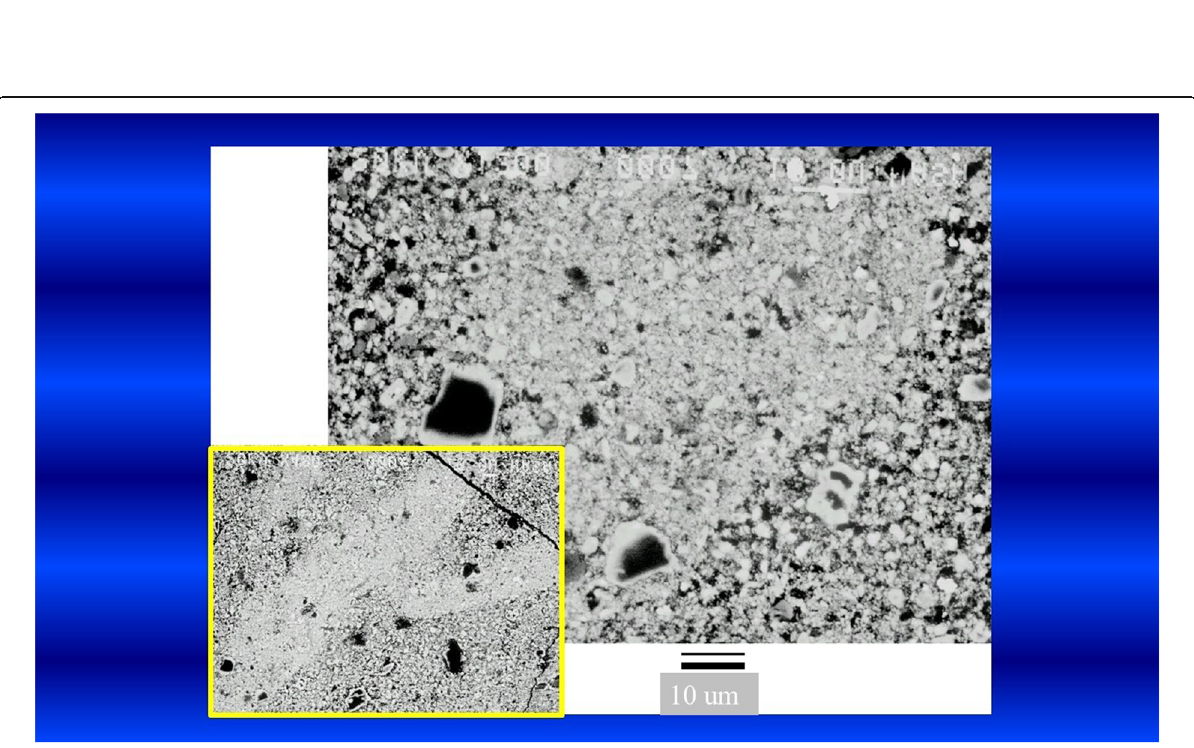
Fig. 18 Close-up on the clast in Fig. 17, showing the bottom of one bed (upper left) with a sharp contact with the top of the succeeding bed (lower right). The mineralogy of the clast is mainly olivine, with Fe-rich olivine being lighter in shade. The highest concentration of light gray, Fe- rich olivine is at the bottom of the bed. Insert image at lower left is a lower mag view of the same area, with the high mag area at the lower left of the insert. Note that the grain size extends down to the micron scale